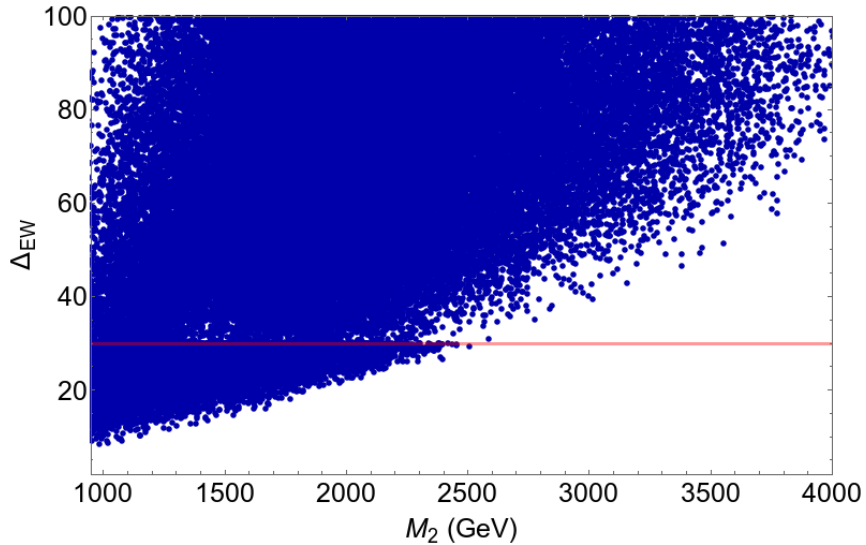
Figure 14 . Plot of (cid:1) EW vs. M 2 (weak) from a scan over natural mini-landscape parameter space with m 0 (1 ; 2) ’ m 3 = 2